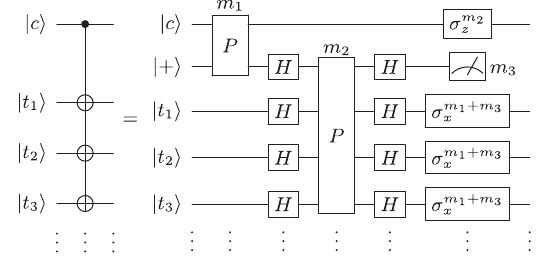
FIG. 6. Quantum circuit for a multitarget CNOT gate using parity measurements and an ancilla qubit initialized in the jþi state. ⊗ σ First, the parity operator σ of the control and ancilla is z z ⊗ σ ⊗ n measured, with outcome m 1 . Next, the parity operator σ x x of the ancilla and n targets is measured, with outcome m 2 . Finally, the ancilla is measured in the computational basis σ , with z outcome m 3 . The three outcomes determine the final correctional operation σ m 2 z ⊗ ð σ m 1 þ m 3 x FIG. 7. Six-qubit parity measurement in a triangular lattice of hexagonal-cell qubits. Six hexagonal-cell qubits, Q 1 – Q 6 , are arranged around an empty cell that is used for the measurement of the parity operator σ ⊗ 6 . For clarity, the Majoranas of each qubit z are colored red and blue in an alternating fashion. The first two Majoranas of each qubit are moved to this cell, such that 12 connected superconductors host 12 Majoranas. The total 12- Majorana parity of this island is precisely the six-qubit parity